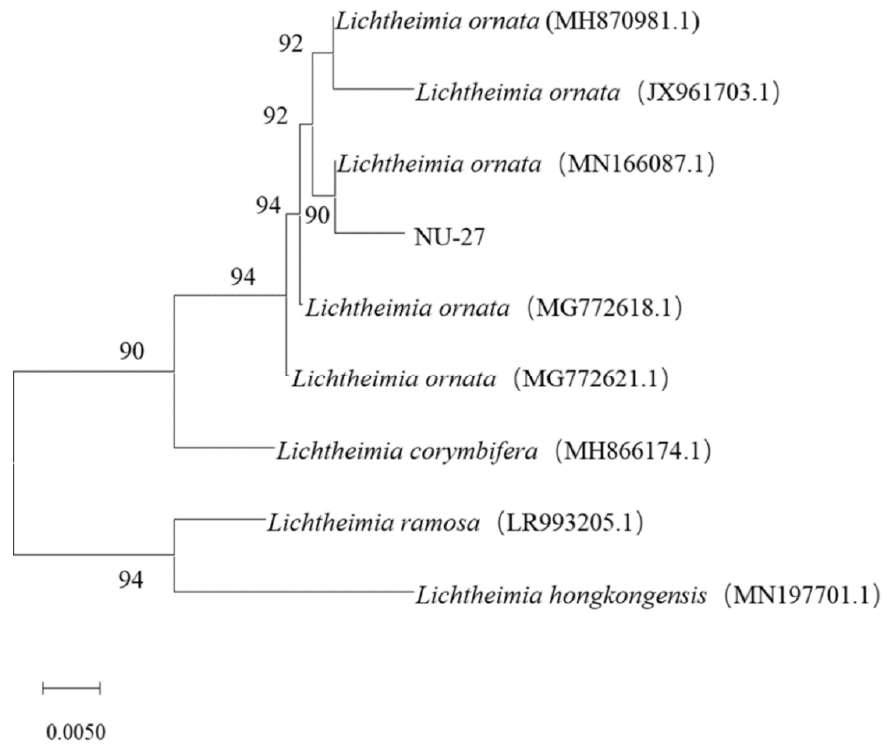
Figure 4. Phylogenetic tree of NCU-27 and Lichtheimia genus based on 26s rRNA gene sequences. GenBank accession numbers of each species are shown in parentheses. Numbers at the nodes indicate bootstrap values (expressed as %) with 1000 replicates, and the scale bar measures the distance between